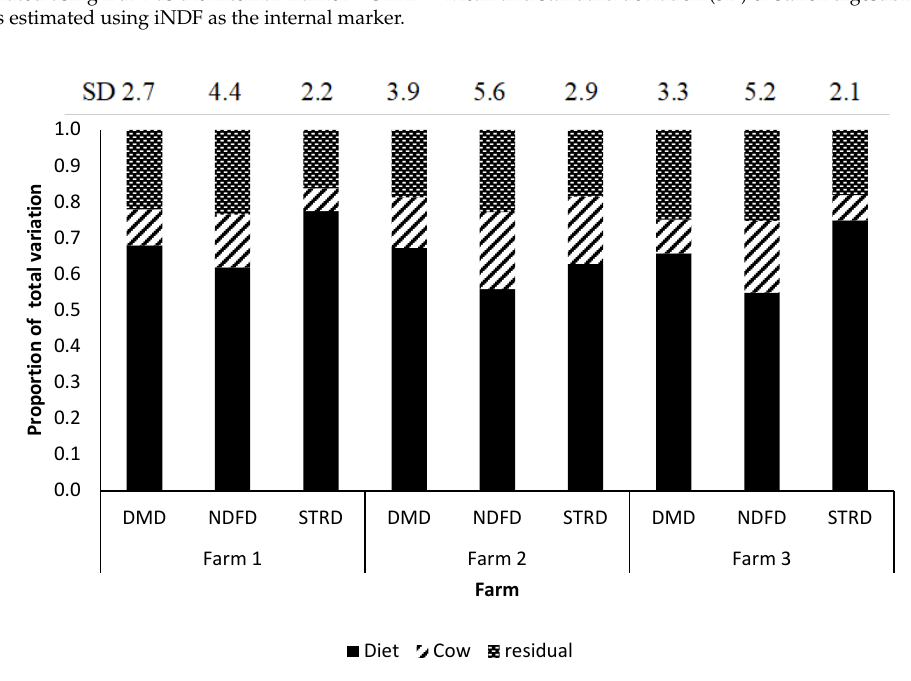
Figure 2. Variance components of nutrient digestibility estimates within farm. Variability are presented as proportion of total within farm variation. DMD = Mean and standard deviation (SD) of dry matter digestibility of cows; NDFD = Mean and standard deviation (SD) of NDF digestibility of cows estimated using iNDF as the internal marker; STRD = Mean and standard deviation (SD) of starch digestibility of cows estimated using iNDF as the internal marker.